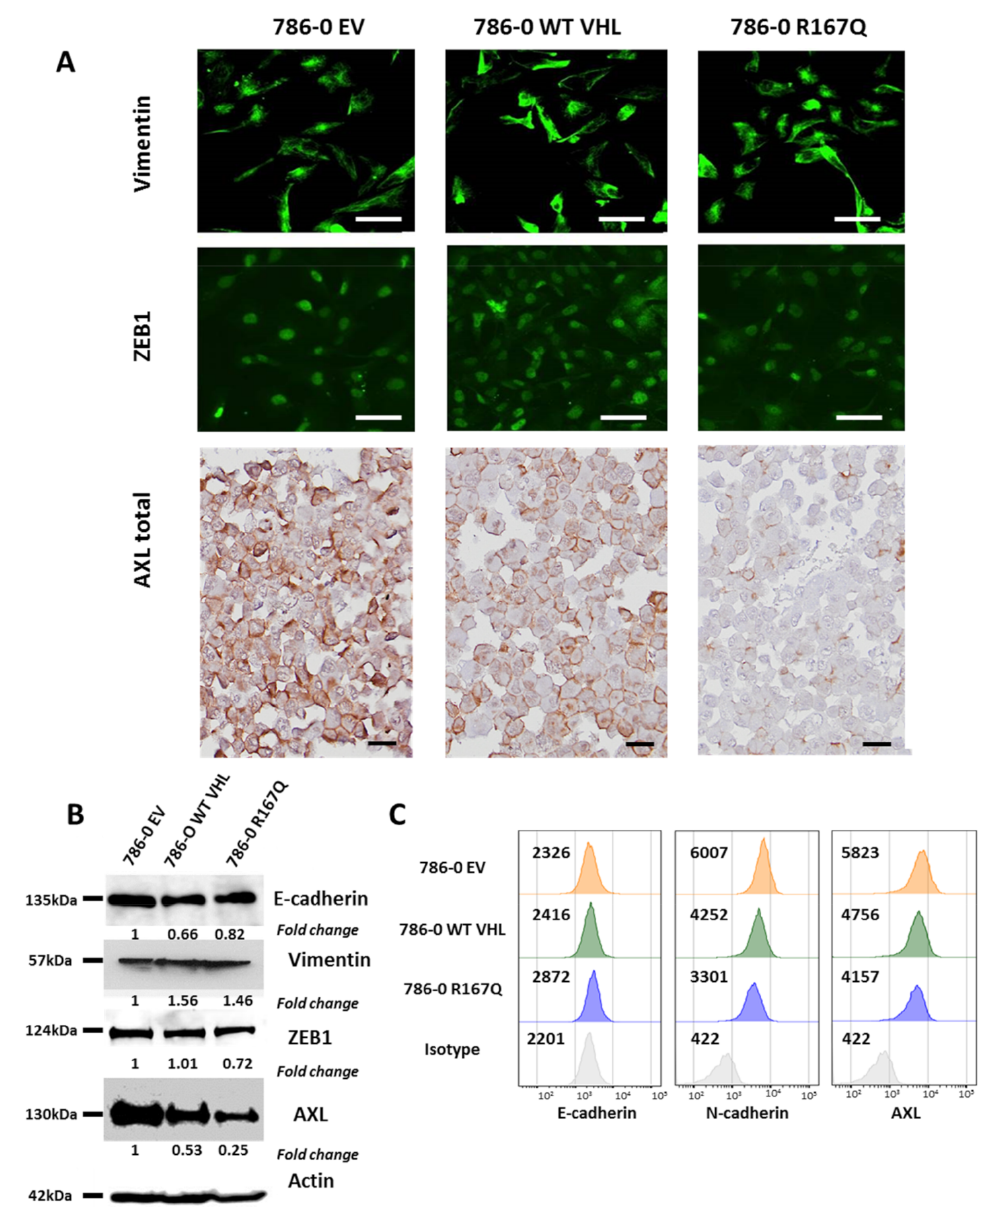
Figure 2. VHL gain of function in VHL-R167Q downregulates AXL expression. ( A ): Staining of vimentin, ZEB-1 and AXL by immunofluorescence (Scale bar, 100 µ m) and immunohistochemistry (FFPE) (Scale bar 25 µ m) on 786-0 EV, 786-0 WT VHL, and 786-0 VHL-R167Q. ( B ): Western blot analysis of E-cadherin, vimentin, ZEB-1, AXL and ACTIN in 786-0 EV, 786-0 WT VHL, and 786-0 VHL R167Q cells, the uncropped western blot figures in Figure S3. ( C ): Representative flow cytometry intensity histogram for E-cadherin, N-cadherin, and AXL on 786-0 EV, 786-0 WT VHL, and 786-0 R167Q cells. Isotype control (Ctrl IgG) is shown in